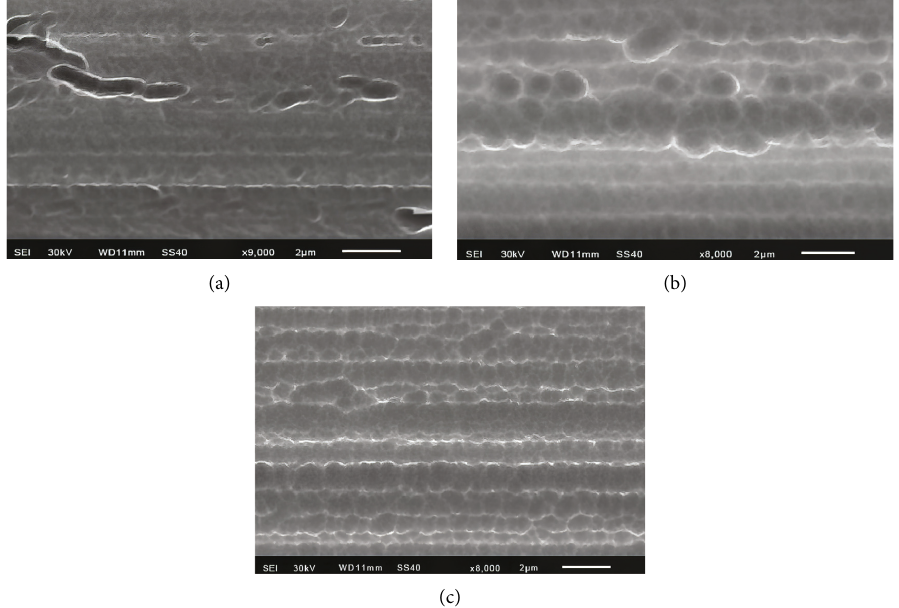
Figure 4: SEM images of DWS-processed and etched mc-Si wafer by recipe-I (a), recipe-II (b), and recipe-III (c).